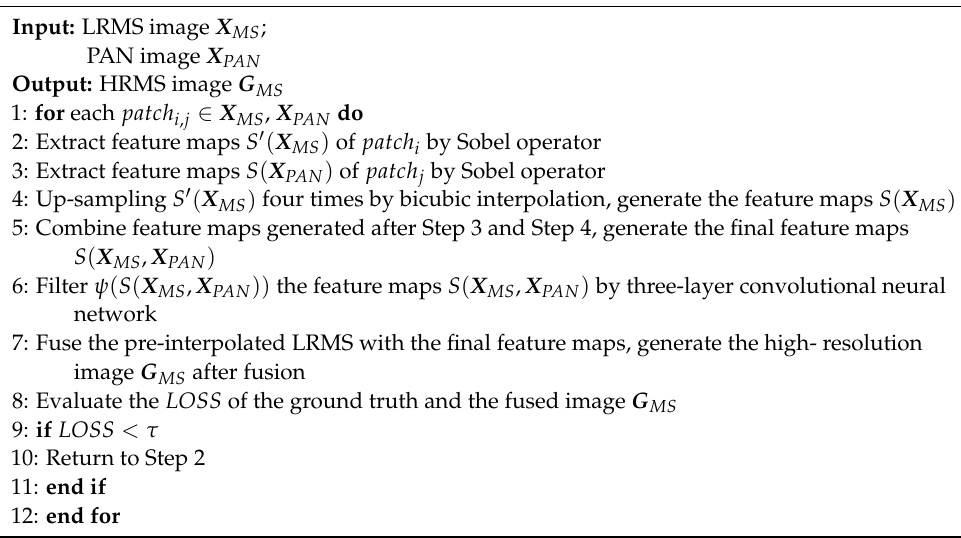
Algorithm 1. Spatial structure enhancement convolution operator pansharpening